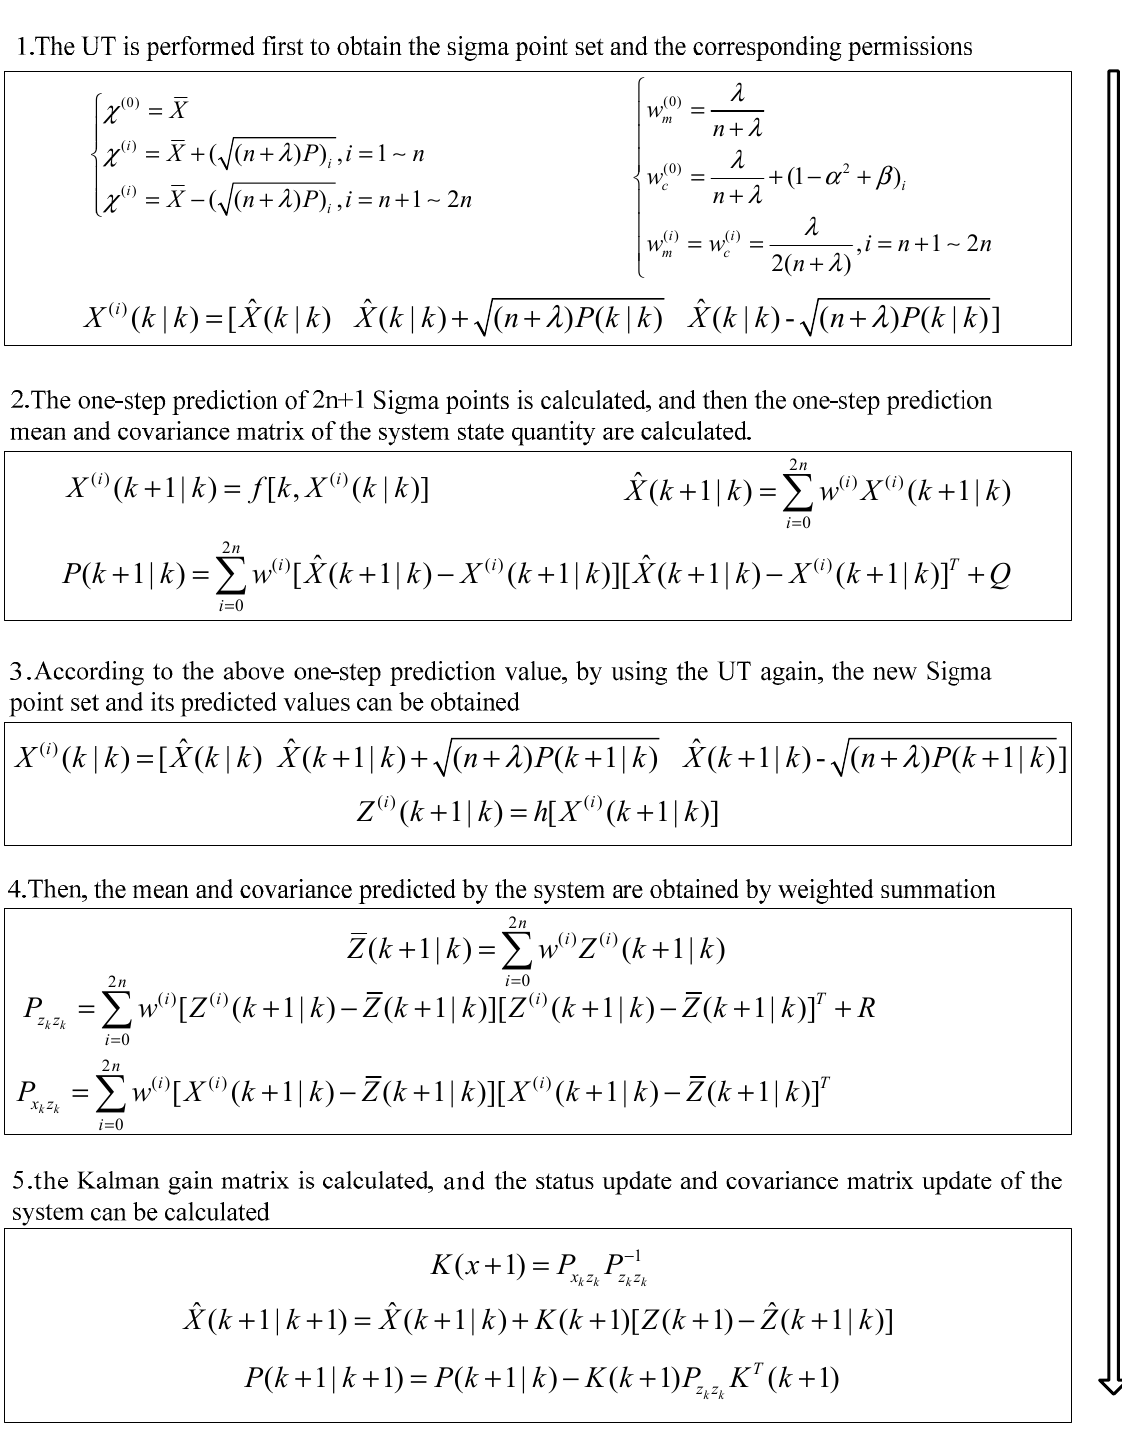
Figure 5. The specific process of UKF algorithm.